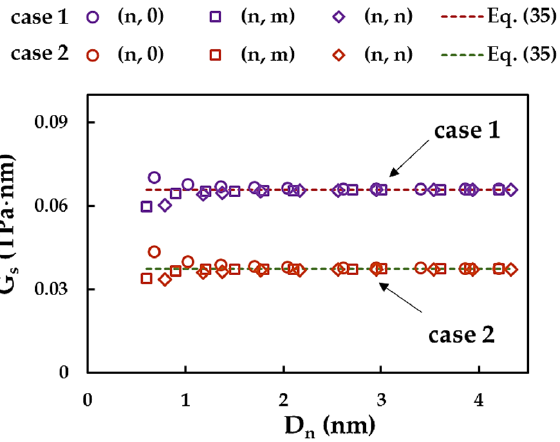
Figure 13. Evolutions of the surface shear modulus, G S , as a function of the NTs diameter, D n , for SWInNNTs.